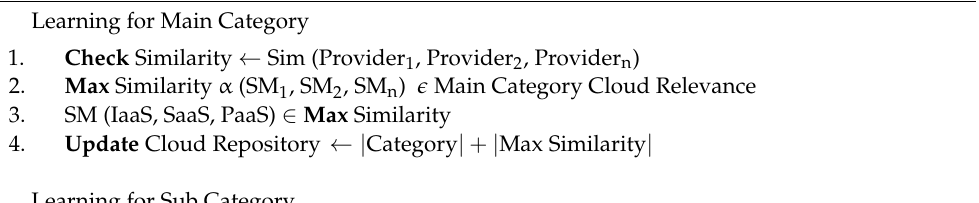
Algorithm 3. Learning Management for Cloud Services Categorization Learning for Main